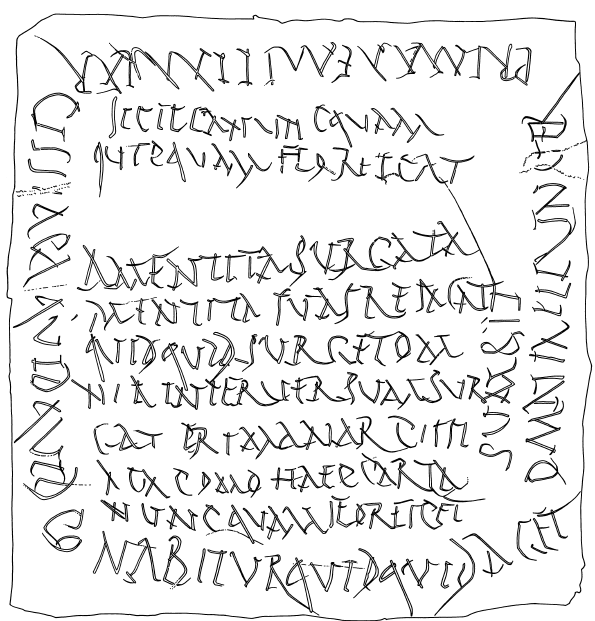
Figure 4: The back of DTM 15 (Blänsdorf 2012: